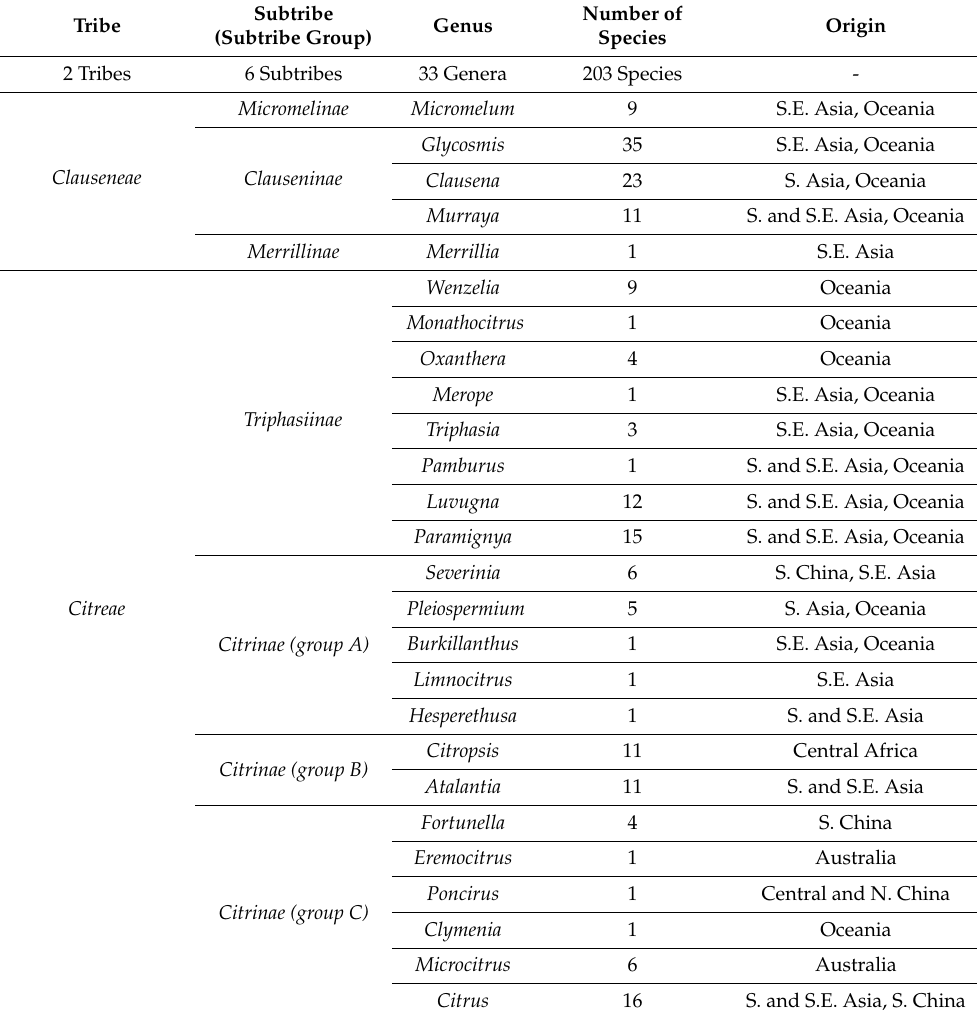
Number of Genus Species